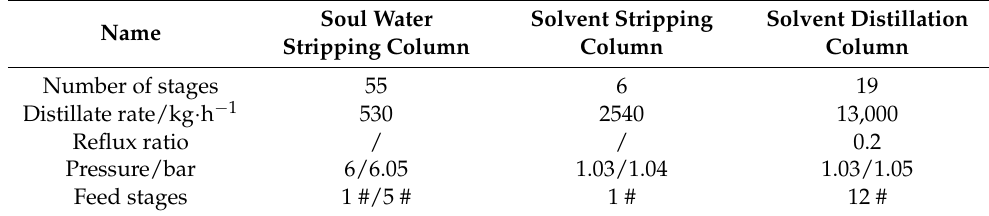
Table 2. Operating parameters of the stripper and distillation columns.